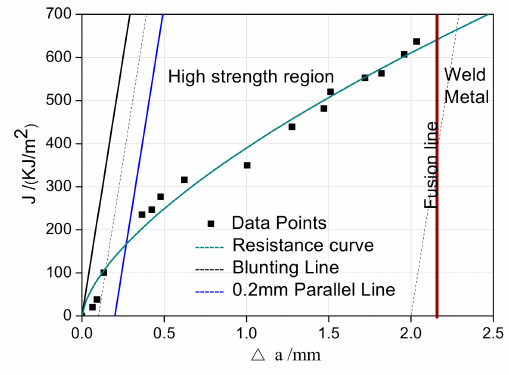
Figure 16. Resistance curves of the HAZ after